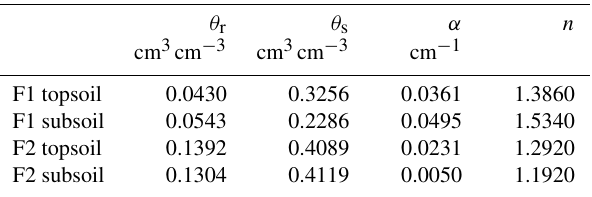
Table 2. Parameters of soil hydraulic properties in the topsoil (0– 30cm) and subsoil (30–120cm) of the stony (F1) and silty (F2) soils. θ r and θ s are residual and saturated soil water content, respec- tively. α and n are curve-fitting